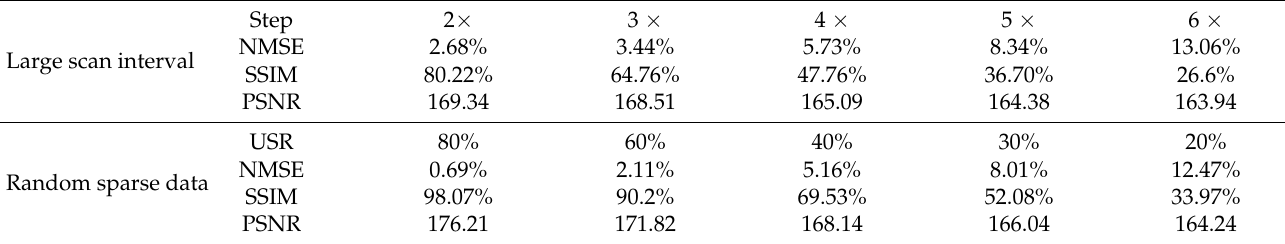
Table 4. NMSE, SSIM, PSNR of reconstructed image in different